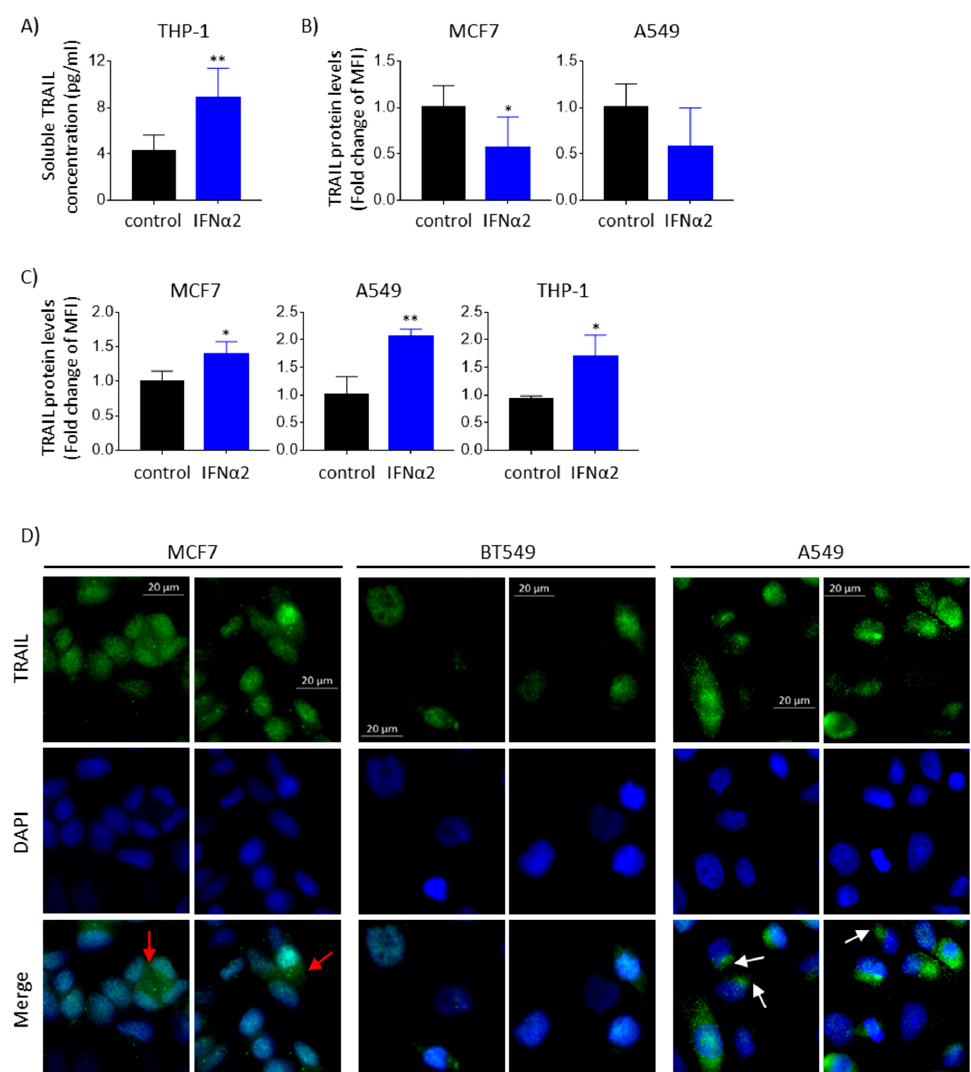
Figure 3. IFN α -induced TRAIL protein accumulates intracellularly in epithelial cancer cells. ( A ) Soluble TRAIL protein levels increased upon IFN α stimulation in THP-1. Cells were treated with 0.8 µ g/mL IFN α 2 for 24 h, and TRAIL protein in the culture media was quantified using ELISA. Two-tailed t -test was performed (** p < 0.01). ( B ) TRAIL protein levels on the cell surface did not increase upon IFN α stimulation in epithelial cancer cells. MCF7 and A549 were treated with 0.8 µ g/mL IFN α 2 for 48 h, and membrane TRAIL protein was quantified in fresh cells using flow cytometry. Two-tailed t -test was performed (* p < 0.05). ( C ) Total TRAIL protein levels increased upon IFN α stimulation in epithelial and immune cancer cells. MCF7, A549 and THP-1 were treated with 0.8 µ g/mL IFN α 2 for 48 h, and total TRAIL protein was quantified in fixed and permeabilized cells using flow cytometry. Two-tailed t -test was performed (* p < 0.05 and ** p < 0.01). ( D ) IFN α -induced TRAIL was detected intracellularly in epithelial cancer cells. Cells were treated with 0.8 µ g/mL IFN α 2 for 24 h (A549) or 48 h (MCF7 and BT549), and total TRAIL protein was quantified using immunofluorescence. TRAIL signal is shown in green. Nuclei were stained with DAPI (blue). Red arrows mark punctuated cytoplasmic TRAIL staining. White arrows mark TRAIL staining in a big compartment next to the cell nucleus. Representative immunofluorescence images are shown. MFI: mean fluorescence